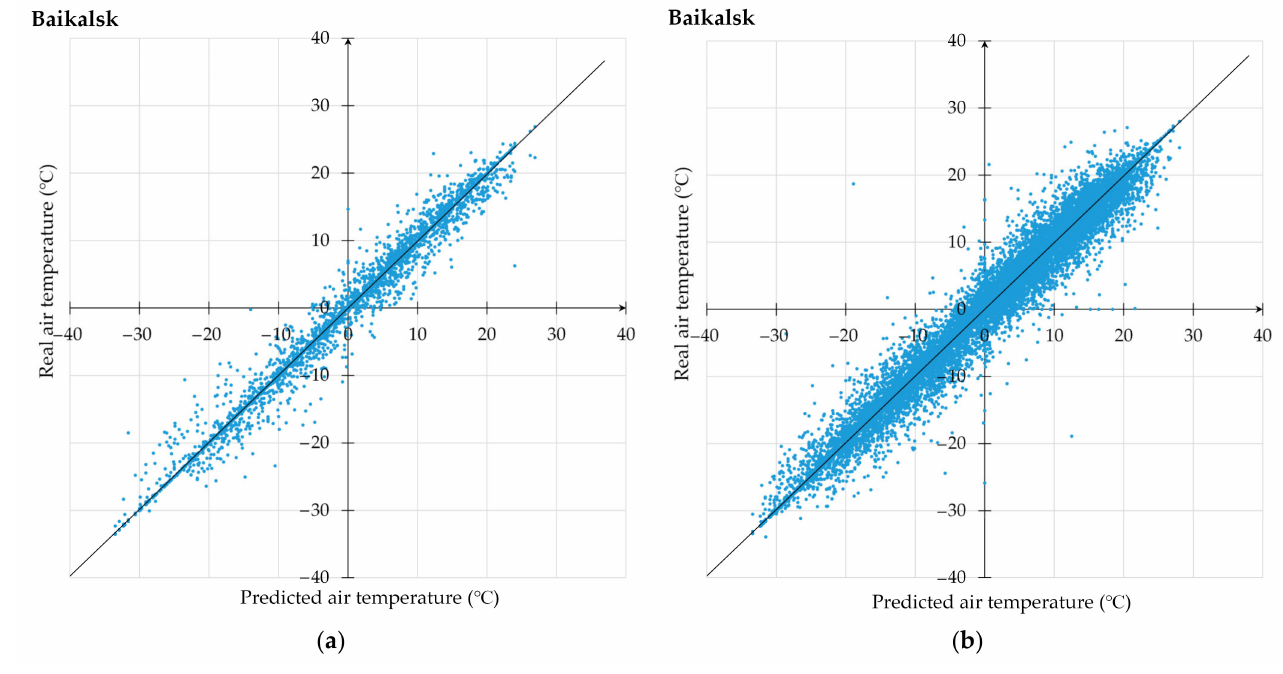
Figure 8. Prediction error scatter of (cid:101) x w Baikalsk.